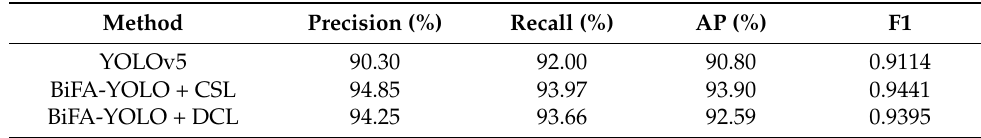
Table 6. Comparison of the methods without and with angular